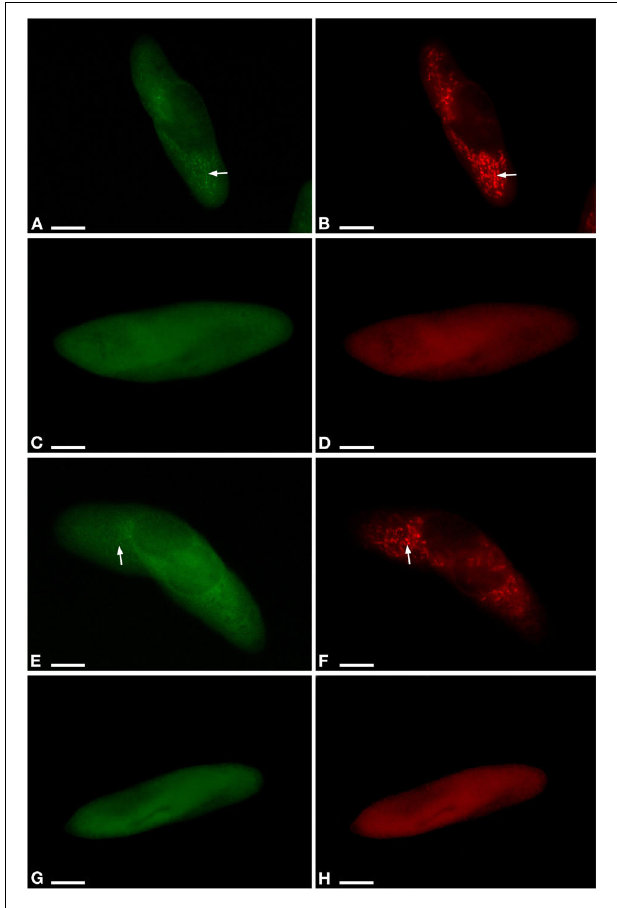
FIGURE 2 | Fluorescent in situ hybridization for the visualization of Ca . M. polyxenophila in Paramecium pentaurelia YE9 (A,B) and Paramecium primaurelia LgJac (E,F) . Fluorescent in situ hybridization for the two symbiont-free cell YE9AB (C,D) and LgJacAB (G,H) after antibiotic treatment using the universal bacterial probe EUB338 (A,C,E,G) and Megenus_487 specific for Ca . Megaira (B,D,F,H) . Arrows indicate Ca . M. polyxenophila in the host’s cytoplasm. Scale bar = 10 µ m.